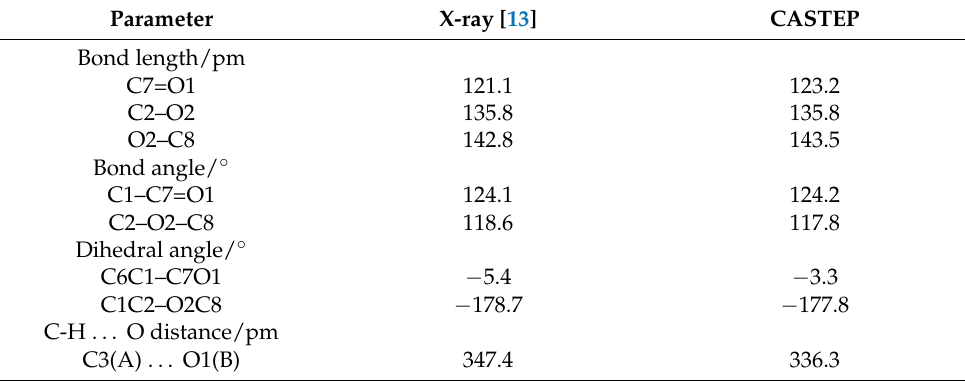
Table 1. Selected geometrical parameters for 2MeOB.